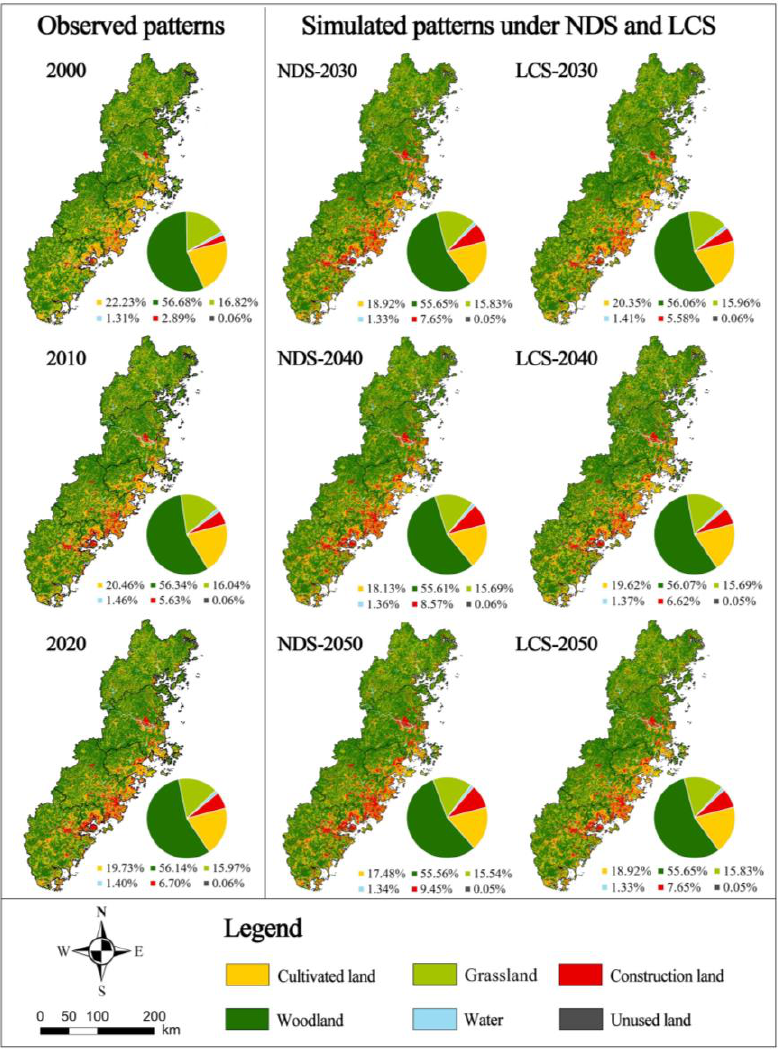
Figure 5. Spatial distribution of landscape types in Fujian coastal area from 2000 to 2050.